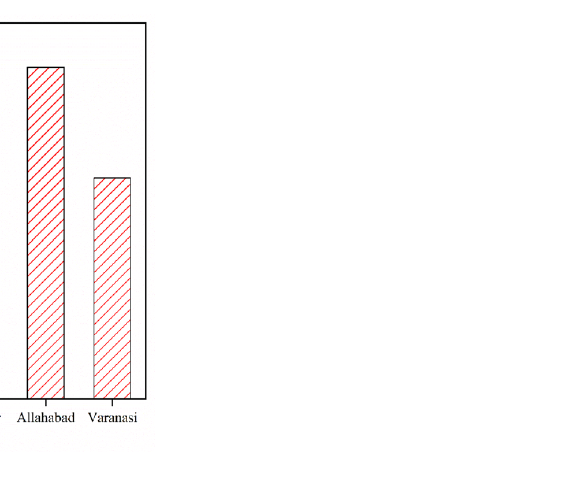
Figure 11. Benefit-to-cost ratio of all